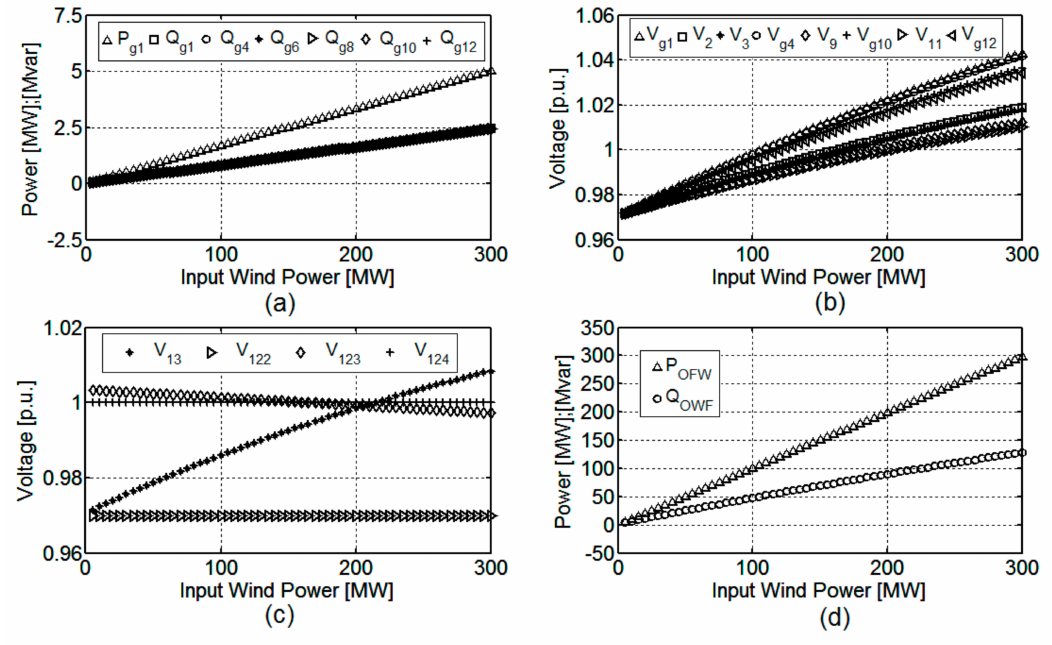
Figure 6. Steady-state curves without optimization (DFIG pf = 0.9): ( a ) Active and reactive power in each DFIG of the first row of the OWF; ( b ) AC voltage modules of the first row of the OWF; ( c ) AC voltage module in the VSC-HVdc model; ( d ) active and reactive power at the collector bus of the